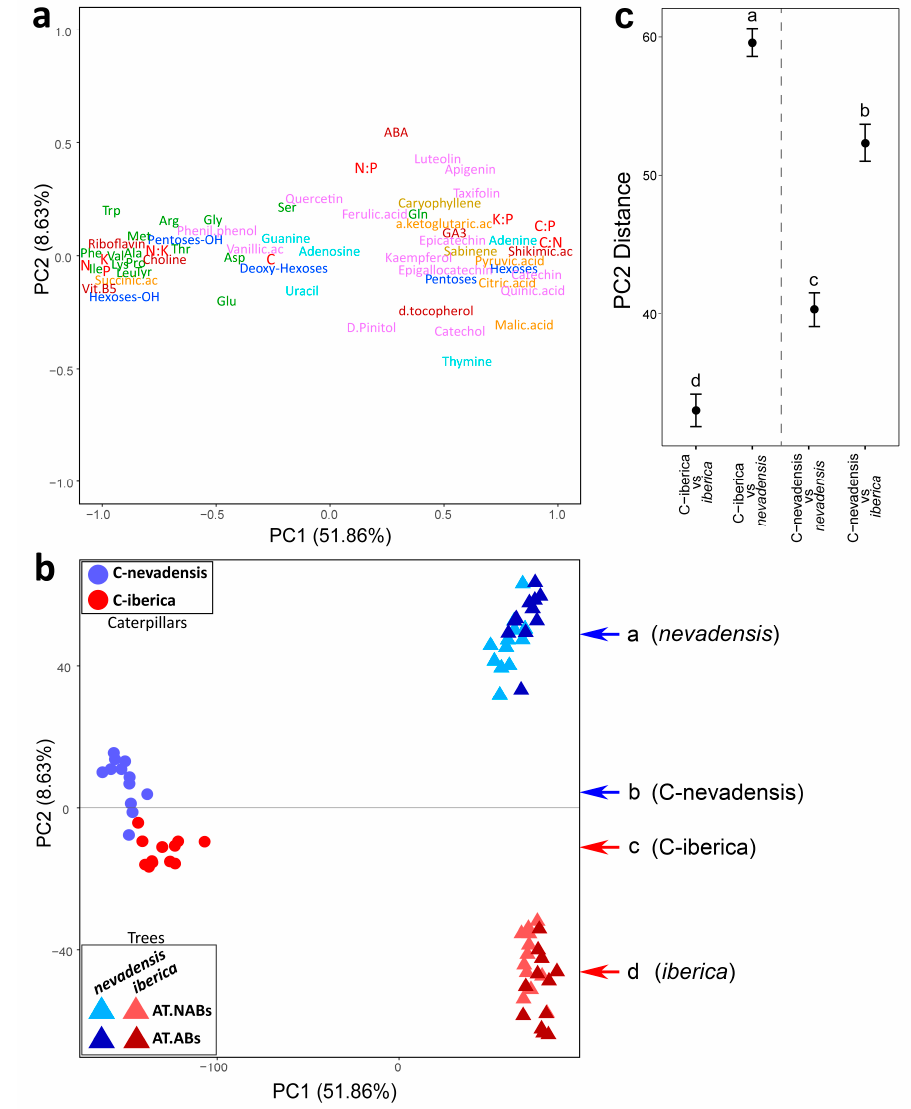
Figure 4. Variable ( a ) and case plot ( b ) of the principal component (PC) 1 vs. the PC2 of the principal component analysis (PCA) including all elemental, stoichiometric and metabolomic data of the dataset of caterpillars and pines (Pine-Caterpillar-Dataset). Only elemental, stoichiometric and identified metabolomic variables are shown in the variable plot ( a ). The location of a variable (element, stoichiometric ratio or metabolite) on the variable plot plane represents the loading value on PC1 vs PC2 for such specific variable. Elemental and stoichiometric variables are shown in red. Metabolite groups are shown in different colors: dark blue, sugars (carbohydrates); green, amino acids; light blue, nucleobases/nucleosides; orange, organic acids related to tricarboxylic acid cycle; violet, phenolic compounds; dark red, other. Case plot ( b ) shows caterpillars feeding on Pinus sylvestris ssp. iberica (C-iberica) in blue circles and caterpillars feeding on Pinus sylvestris ssp. nevadensis (C-nevadensis) in red circles. Needle samples of attacked branches (AT.ABs) and non-attacked branches from attacked trees (AT.NABs) are shown in dark and light blue for Pinus sylvestris ssp. Iberica, and dark and light red for Pinus sylvestris ssp. nevadensis . Different letters next to each colored arrow denote significant difference between groups of samples after Tukey’s HSD post-hoc test ( P < 0.05). One-way ANOVA plot ( c ) contrasting the metabolomic distances along the PC2 of the PCA between caterpillars and pines. Different letters indicate significant difference after Tukey’s HSD post-hoc test ( P < 0.05). Not attacked trees are not represented in the PCA. Detailed discussion of the effects of the caterpillar on pines metabolism has been already published elsewhere [23,36].